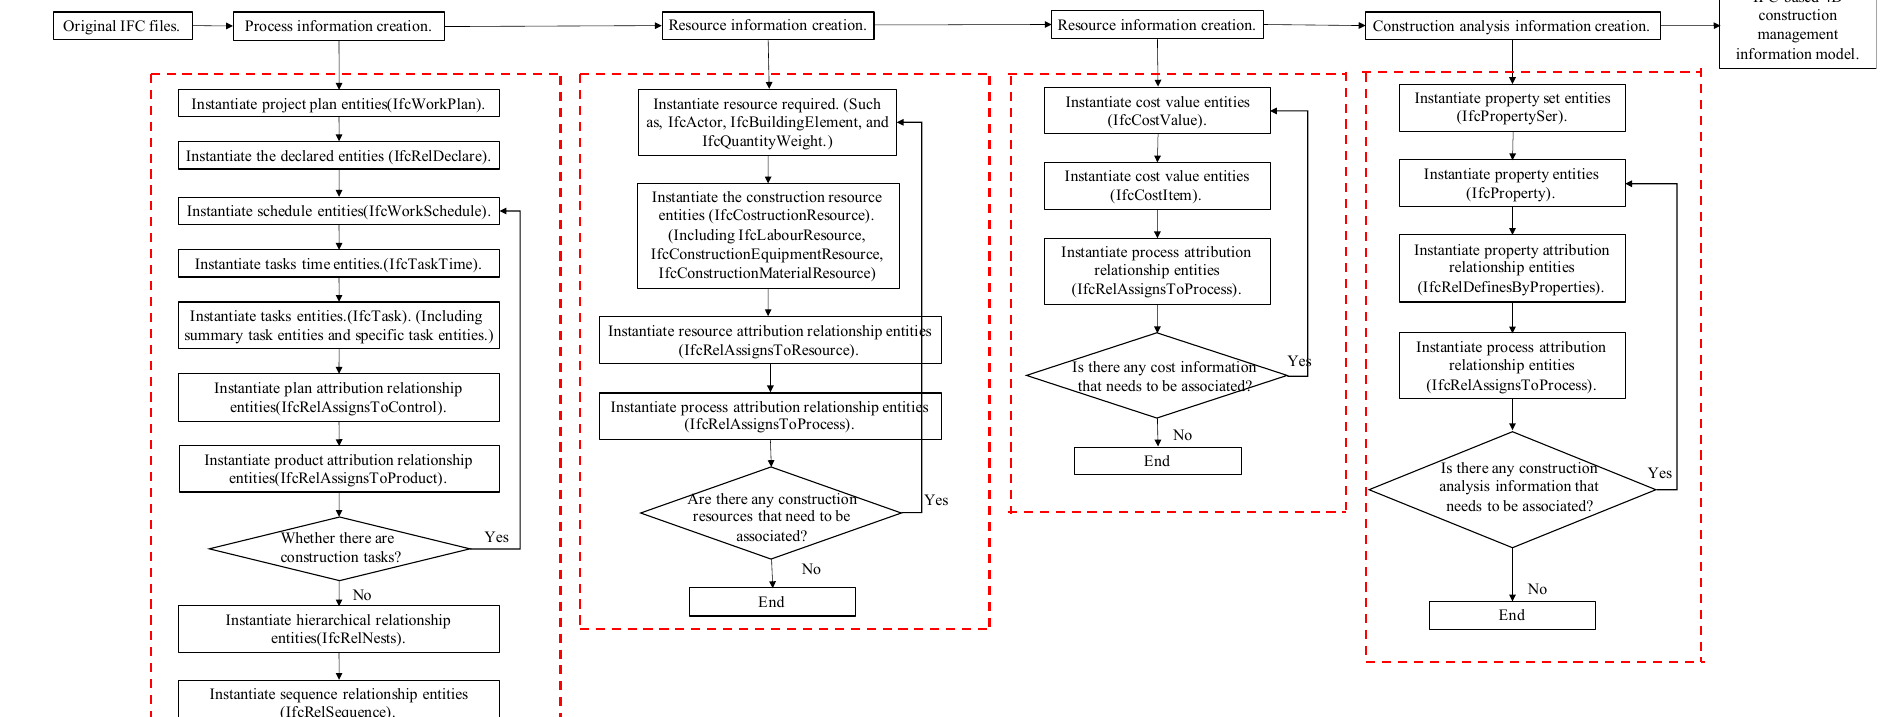
Figure 7. Flow chart of instantiating construction management